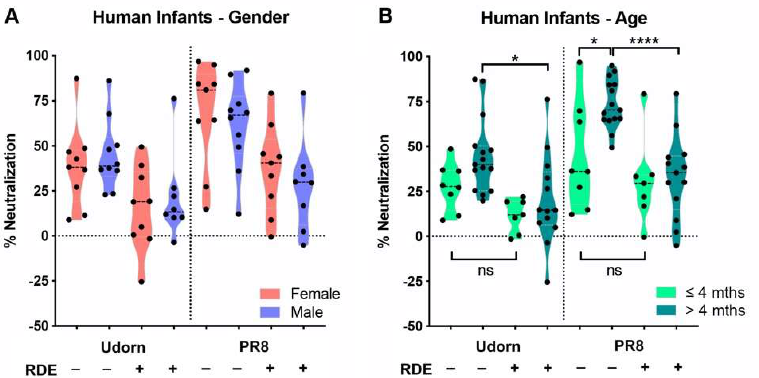
Figure 4. E ff ects of infant gender and age on inhibition of IAV by human saliva. PR8 or Udorn virus (5000 PFU) were added to untreated or RDE-treated saliva from ( A ) male or female infants or ( B ) infants of di ff erent ages ( ≤ or > 4 months) and the percent neutralization determined as described in Figure 2. Violin plots depicting the mean of each group and probability density of the data are shown and represent the results from individual human infant saliva samples tested at least in triplicate.